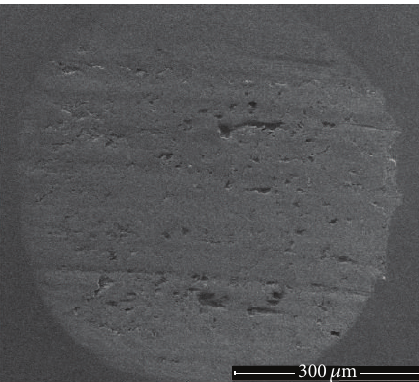
Figure 8: SEM image of a ball which initially run on Oil A for 60min and then on Oil A1 without changing the surface contact for 75 min.